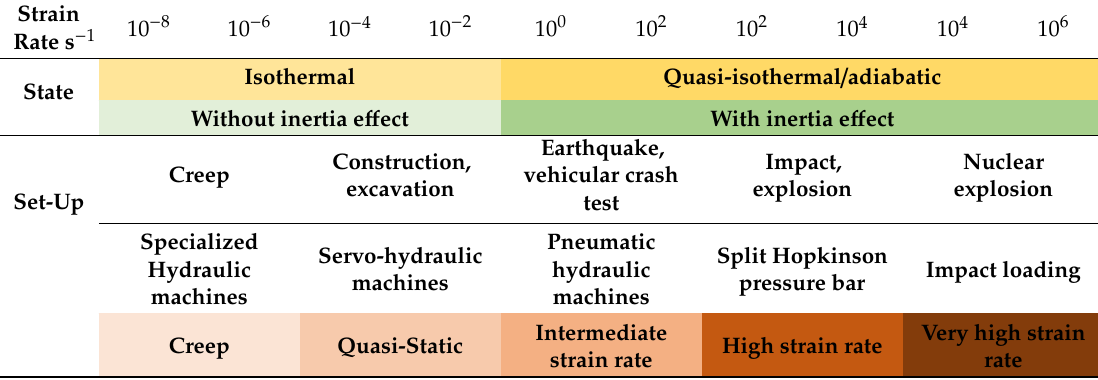
Table 1. Definition of the devices used to deliver the range of strain rates in mechanical